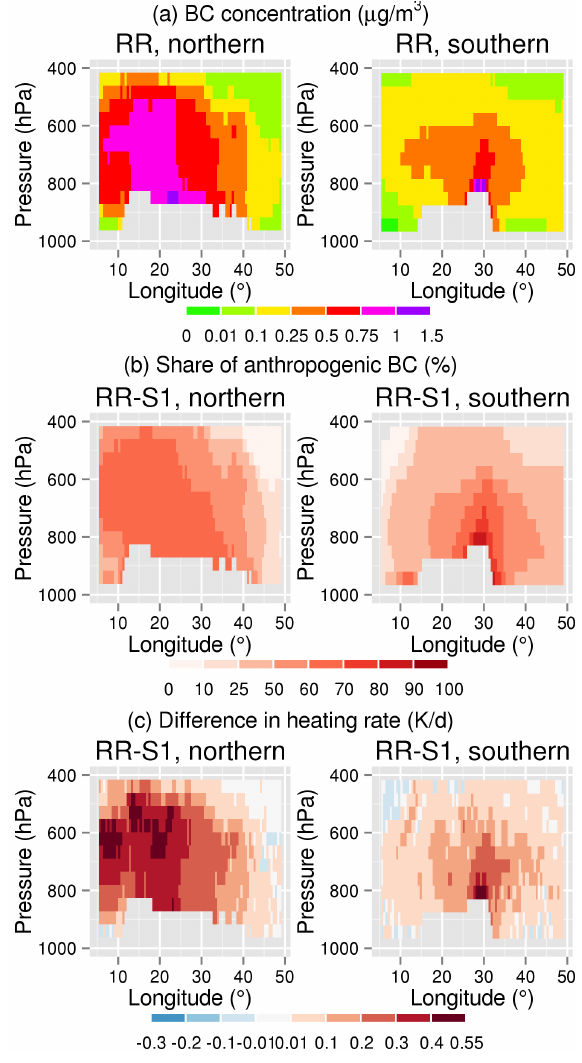
Figure 11. Vertical BC distribution (a) , anthropogenic contribution to BC concentrations (b) and contribution of anthropogenic BC to atmospheric heating rates (c) . All figures show the monthly mean results for September 2010.